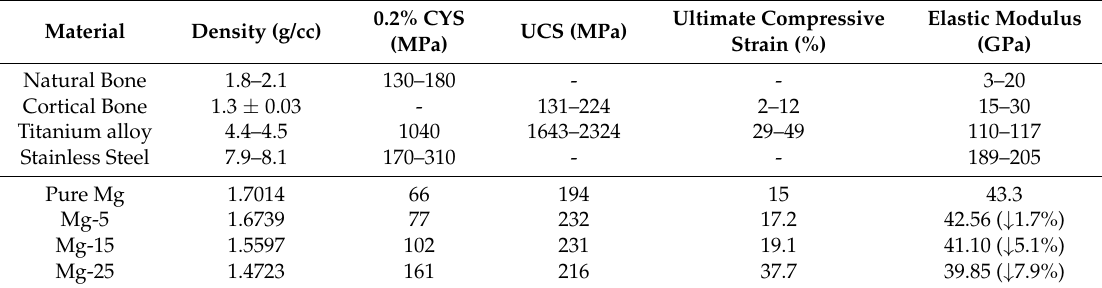
Table 3. Elastic modulus measurements of Mg and their syntactic foams along with comparison of biomechanical